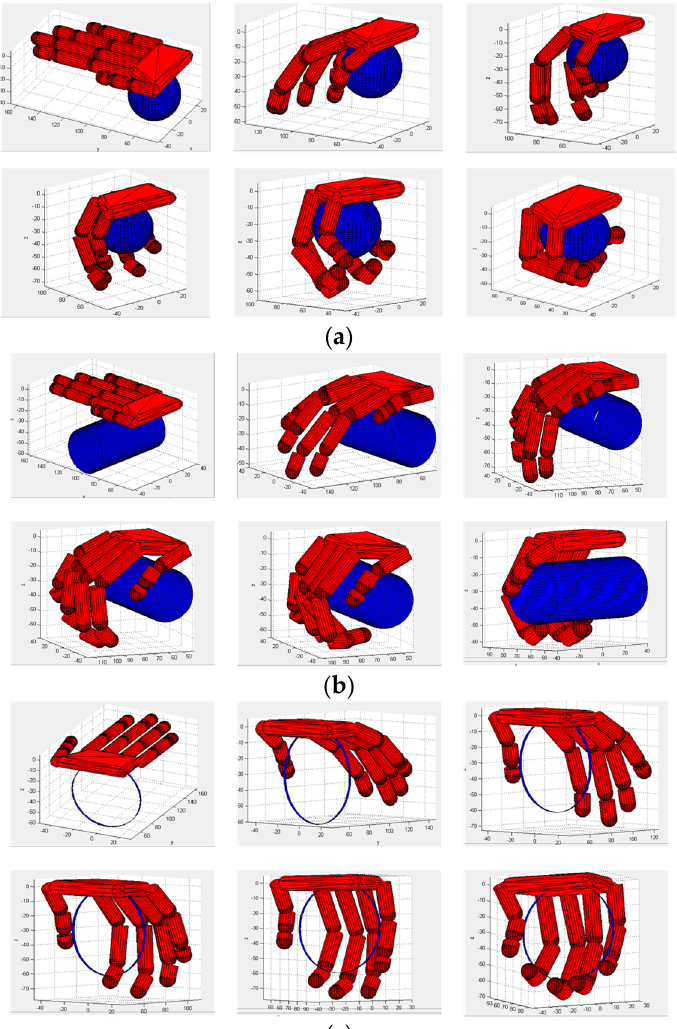
Figure 15. Control of manipulator model to complete grasping tasks: ( a ) power-sphere motion, ( b ) large-diameter motion and ( c ) power-disk motion.